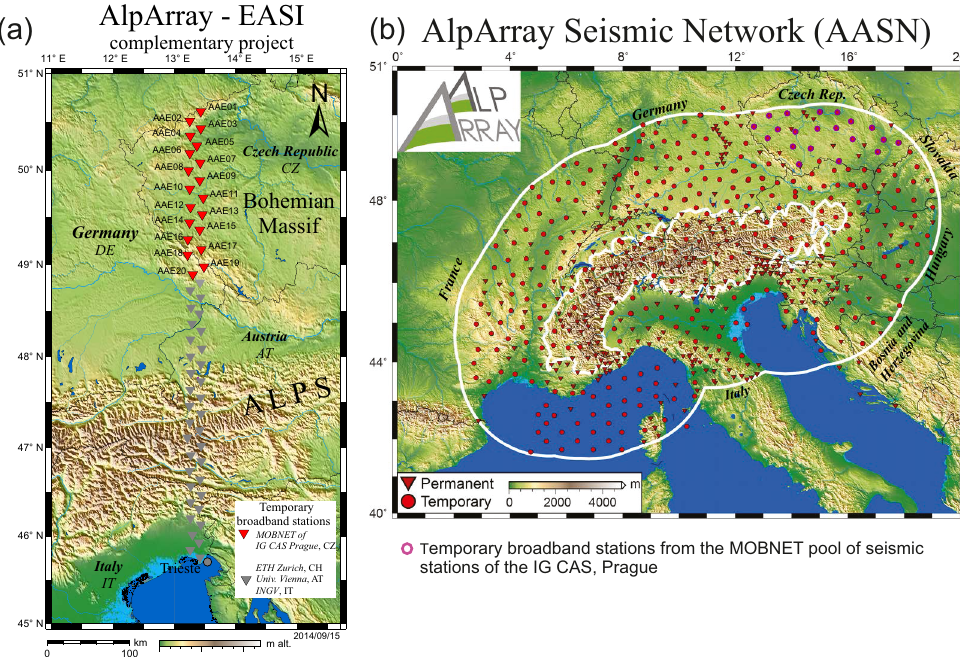
Figure 1. Broadband stations of the MOBNET pool involved in the AlpArray project: (a) in the network of the AlpArray-EASI complemen- tary project (2014–2015) and (b) in the AlpArray Seismic Network (AASN). The broadband stations of the complete AASN cover the area within 250km distance (outer white curve) from the smoothed 800m altitude line of the Alps (inner white curve). The array consists of 623 stations including 30 ocean-bottom seismometers (OBS) in the Ligurian Sea.